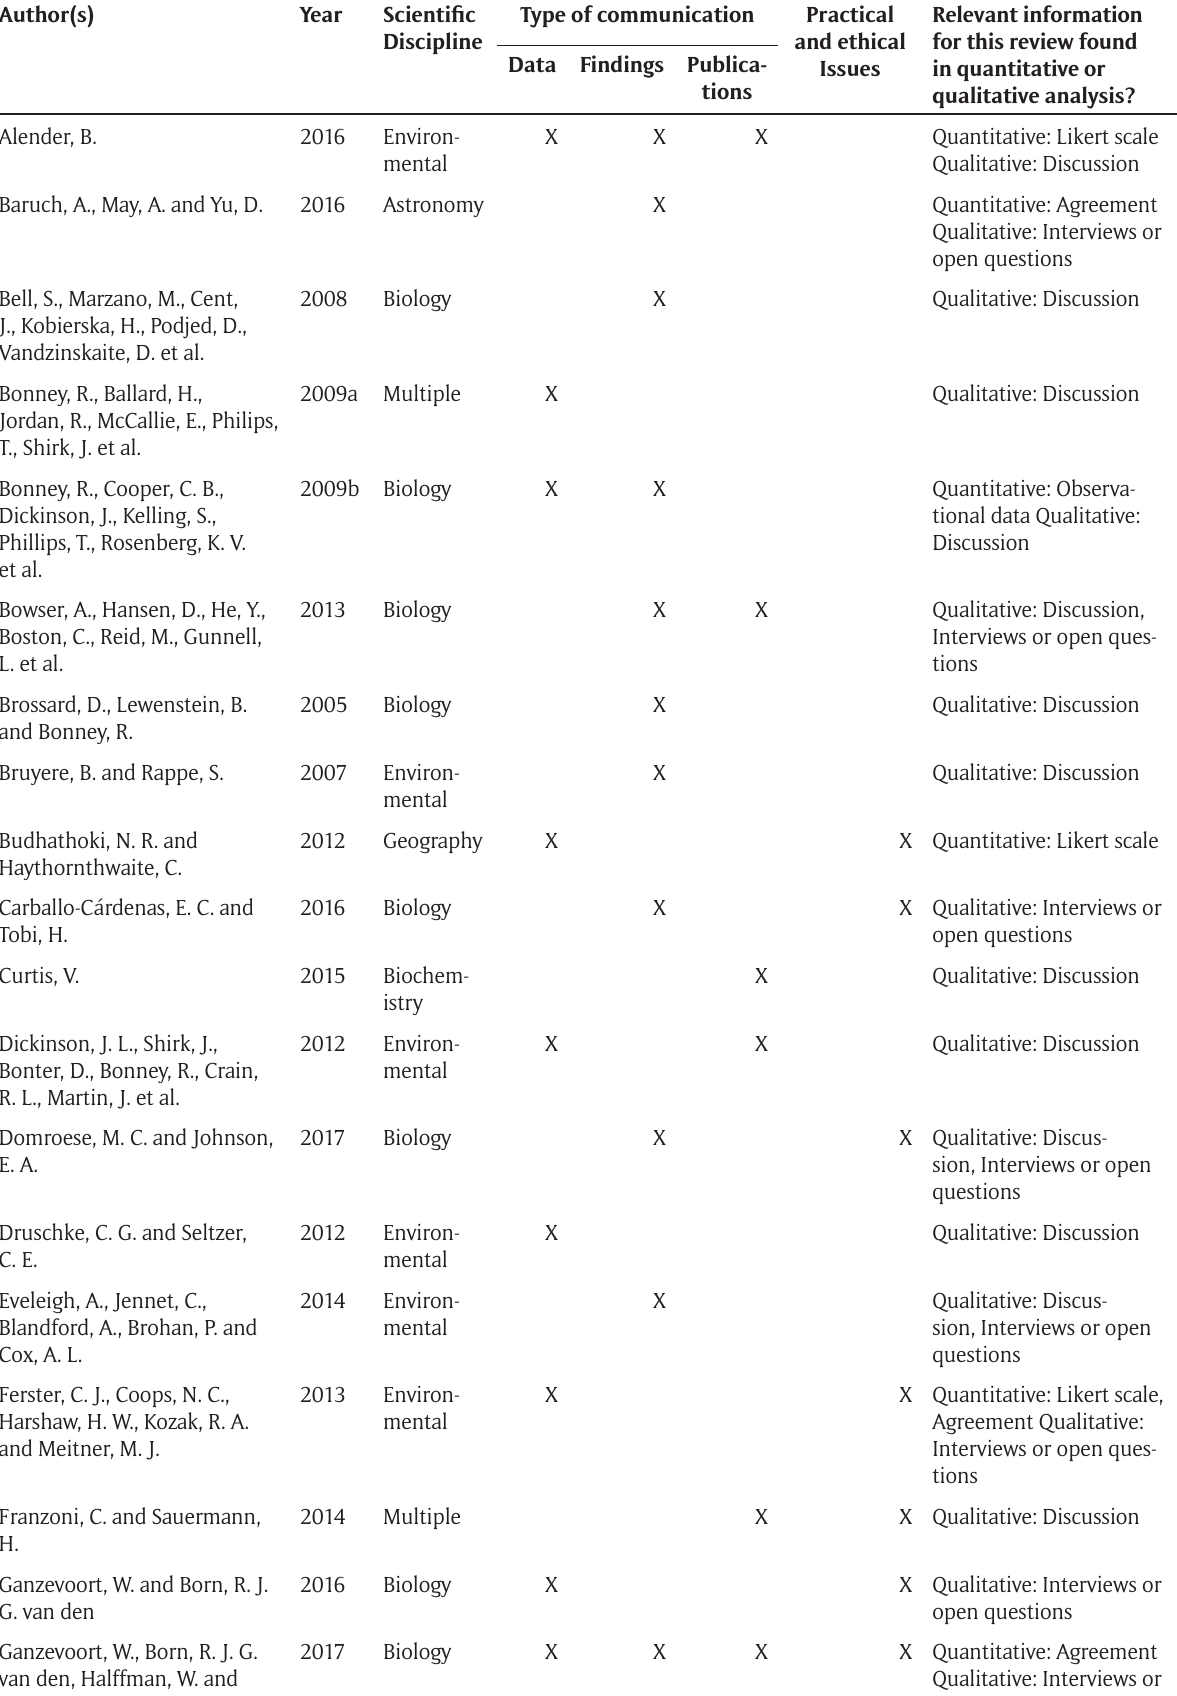
Table 1: Overview of studies included in this literature review. Author(s)